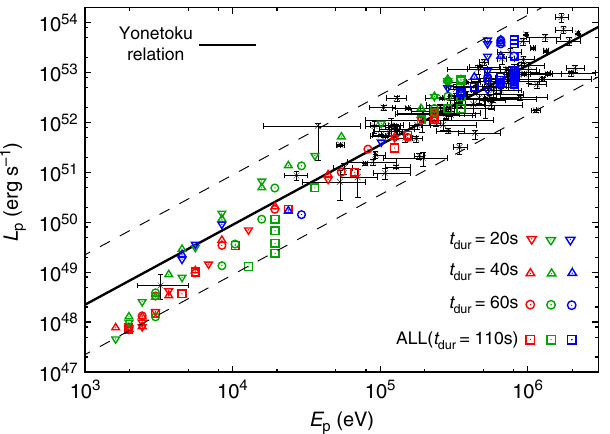
Fig. 4 Relation between time-resolved spectral peak energy E p and peak luminosity L p . Same as Fig. 3, but for a spectral peak energy and peak luminosity computed in fi ve time intervals of Δ t = 10 s successively taken within an observer time t obs = 50 s. The error bars of the observational data indicate 1- σ standard error for both E p and L